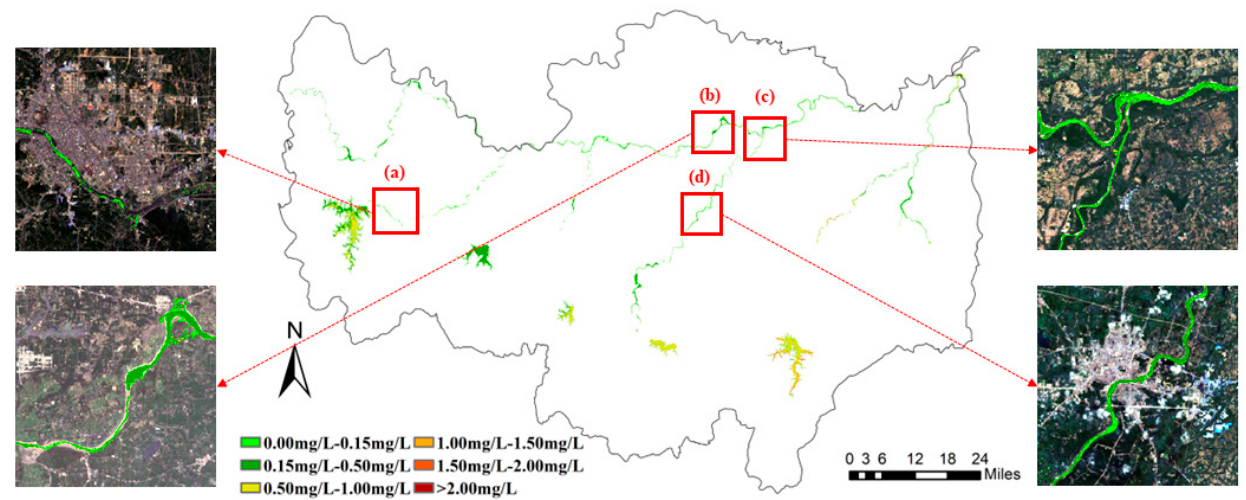
Figure 9. NH 3 -N concentration distribution in January 2017.